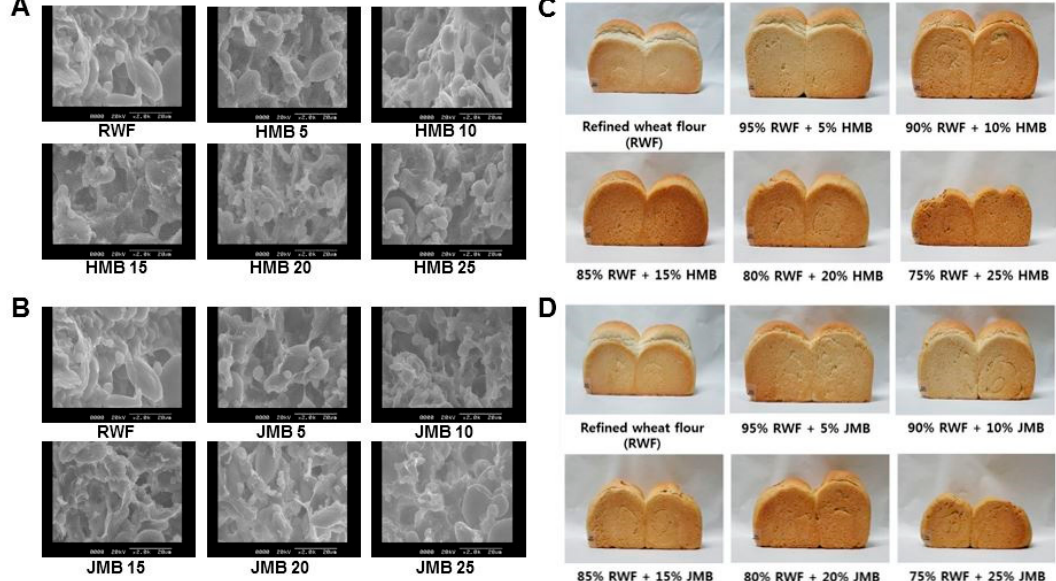
Figure 2. Scanning electron microscopy (SEM, × 2000) images of dough and bread made with various substitution ratios (0%, 5%, 10%, 15%, 20%, 25%) of ( A , C ) HMB or ( B , D ) JMB. HMB: bran pulverized by hammer mill, JMB: bran pulverized by jet